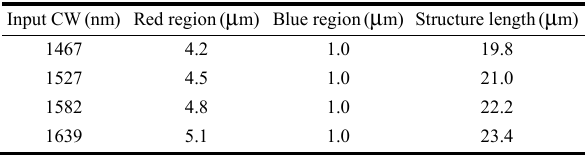
Table 2 Input parameters for grating structure in FullWAVE (Synopsys